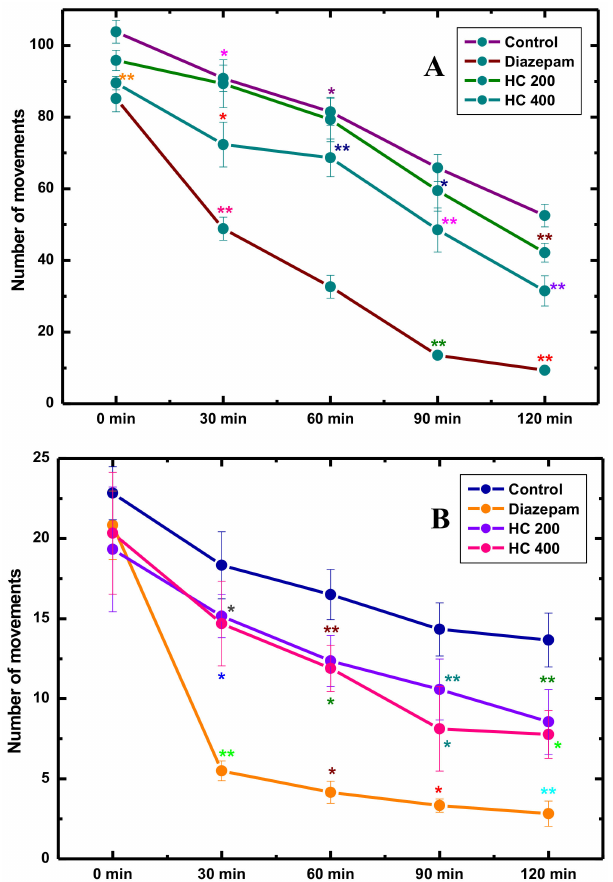
Figure 3. Locomotor and exploratory activities of MEHC and diazepam on open field ( A ) and hole cross ( B ) test in mice. Values are mean ± S.E.M. (* p < 0.05) and (** p < 0.01), significantly di ff erent from control; ANOVA followed by Dunnett’s test ( n = 6, per group). MEHC: methanol extract of Holigarna caustica leaves; HC 200, methanol extract of H. caustica 200 mg / kg; HC 400, methanol extract of H. caustica 400 mg / kg; Reference drug diazepam 1 mg /